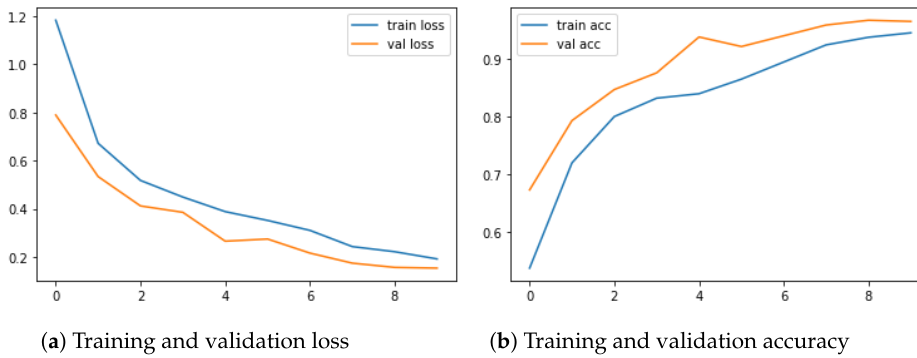
Figure 6. Classification performance of the VGG16 model.